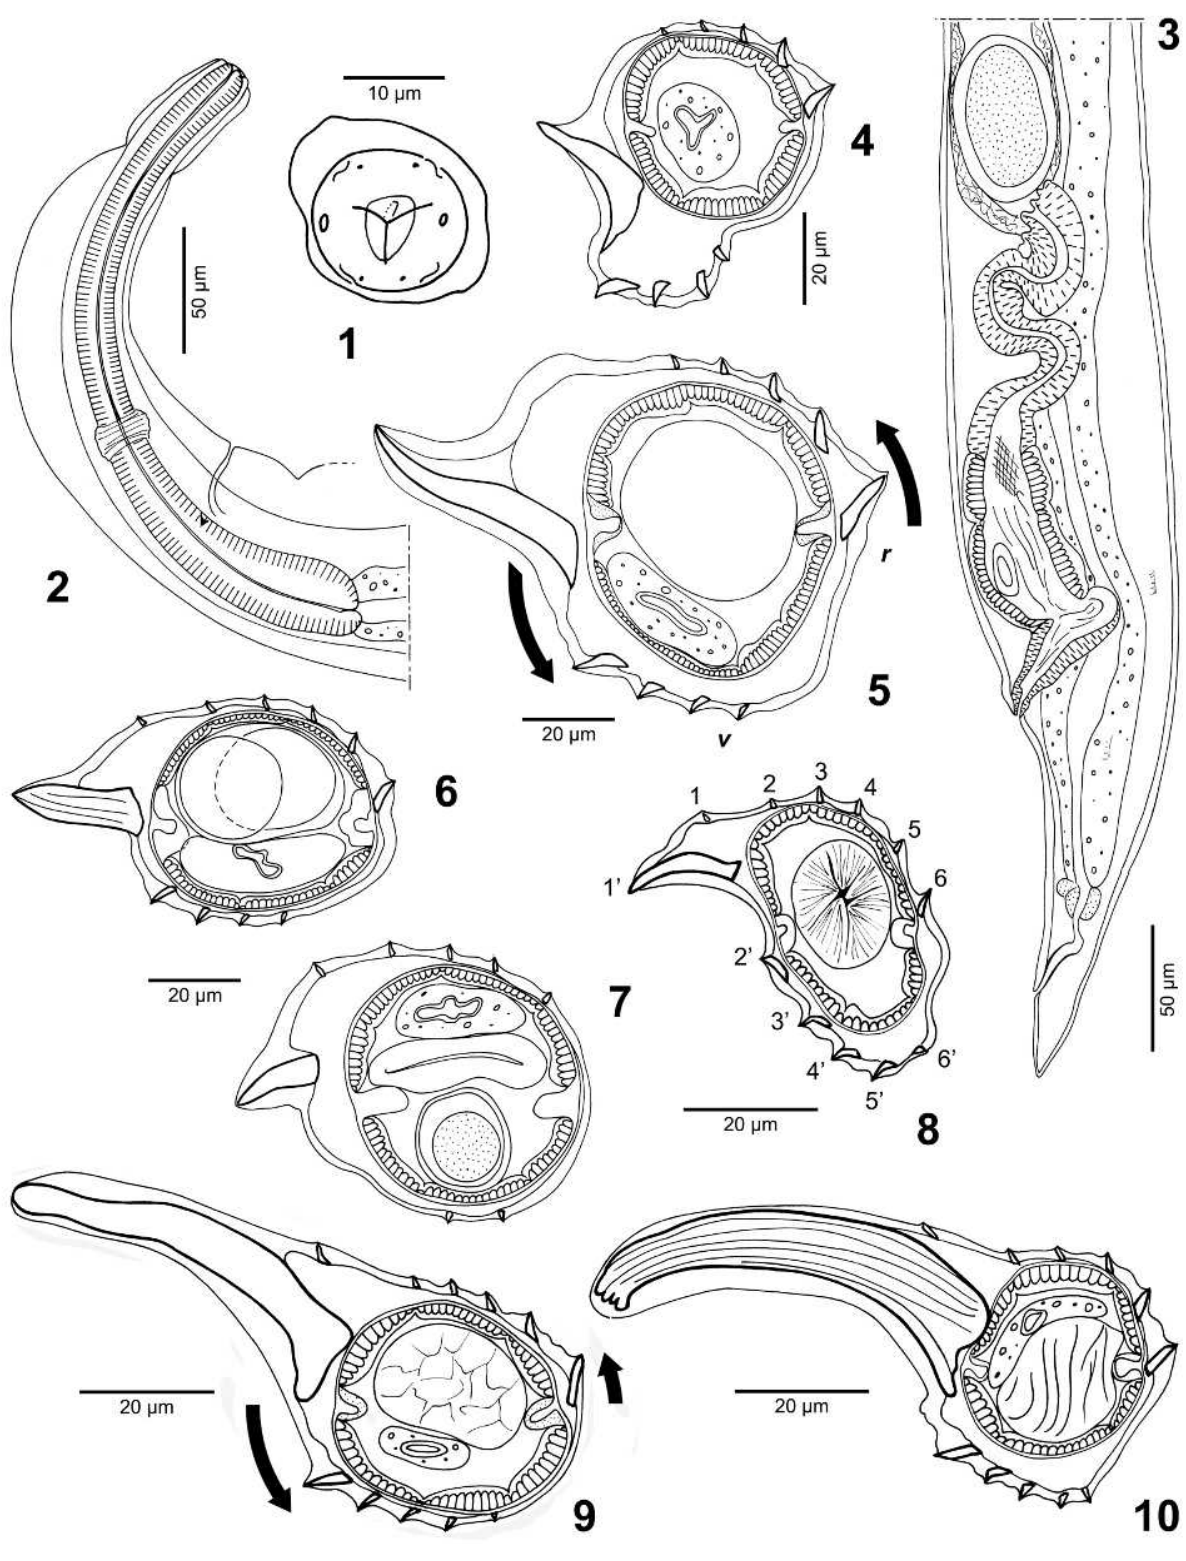
5 - at mid-body (1.9 mm from apex). 6 - At 900 µm anterior to vulva. 7 - at level of vagina vera . 8-10. Male paratype 3.3 mm long. 8 - just anterior to oesophageal intestinal junction. 9 - at mid- body (1.8 mm from apex). 10 - within posterior part of body. All sections are orientated as 5. Abbreviations: v: ventral side, r: right